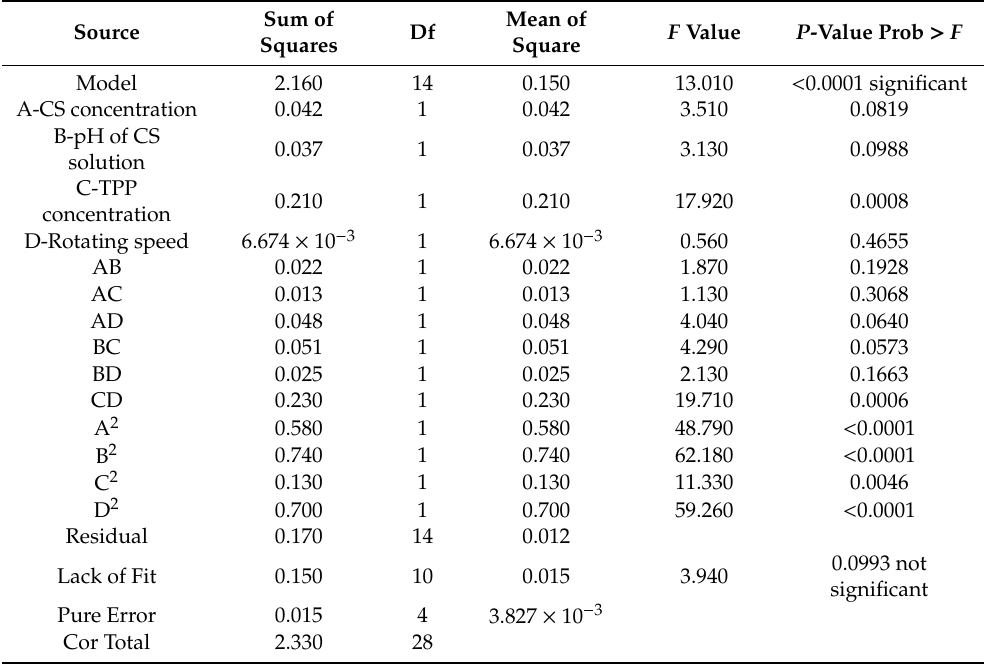
Table 3. Regression coe ffi cient and analysis of variance (ANOVA) for each